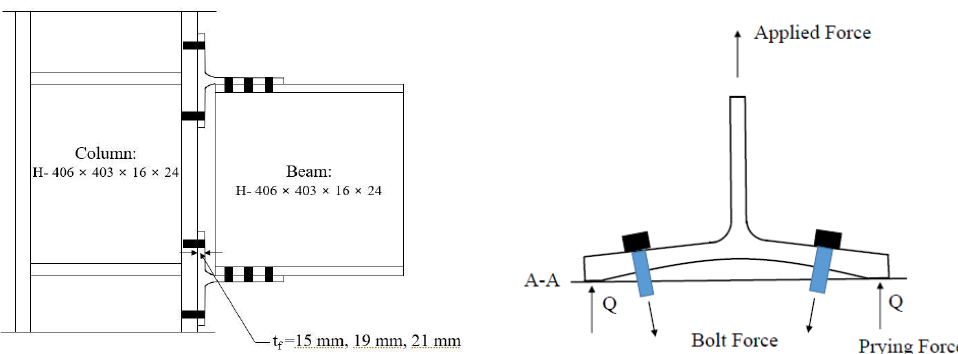
Figure 1. Bolted steel T-stub connection schematic and deformation of T-stub.